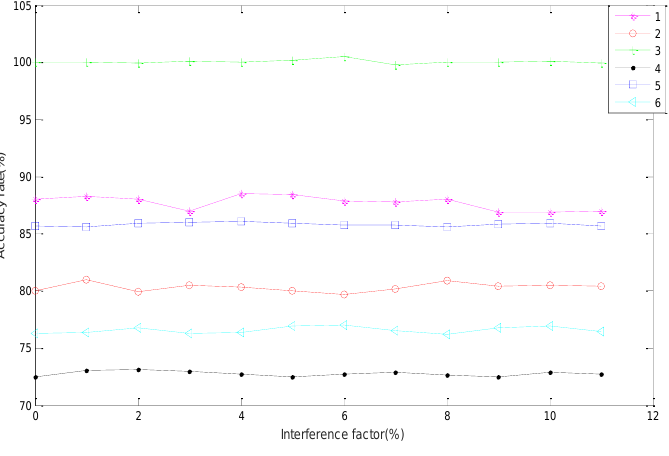
Figure 3. Robustness test.